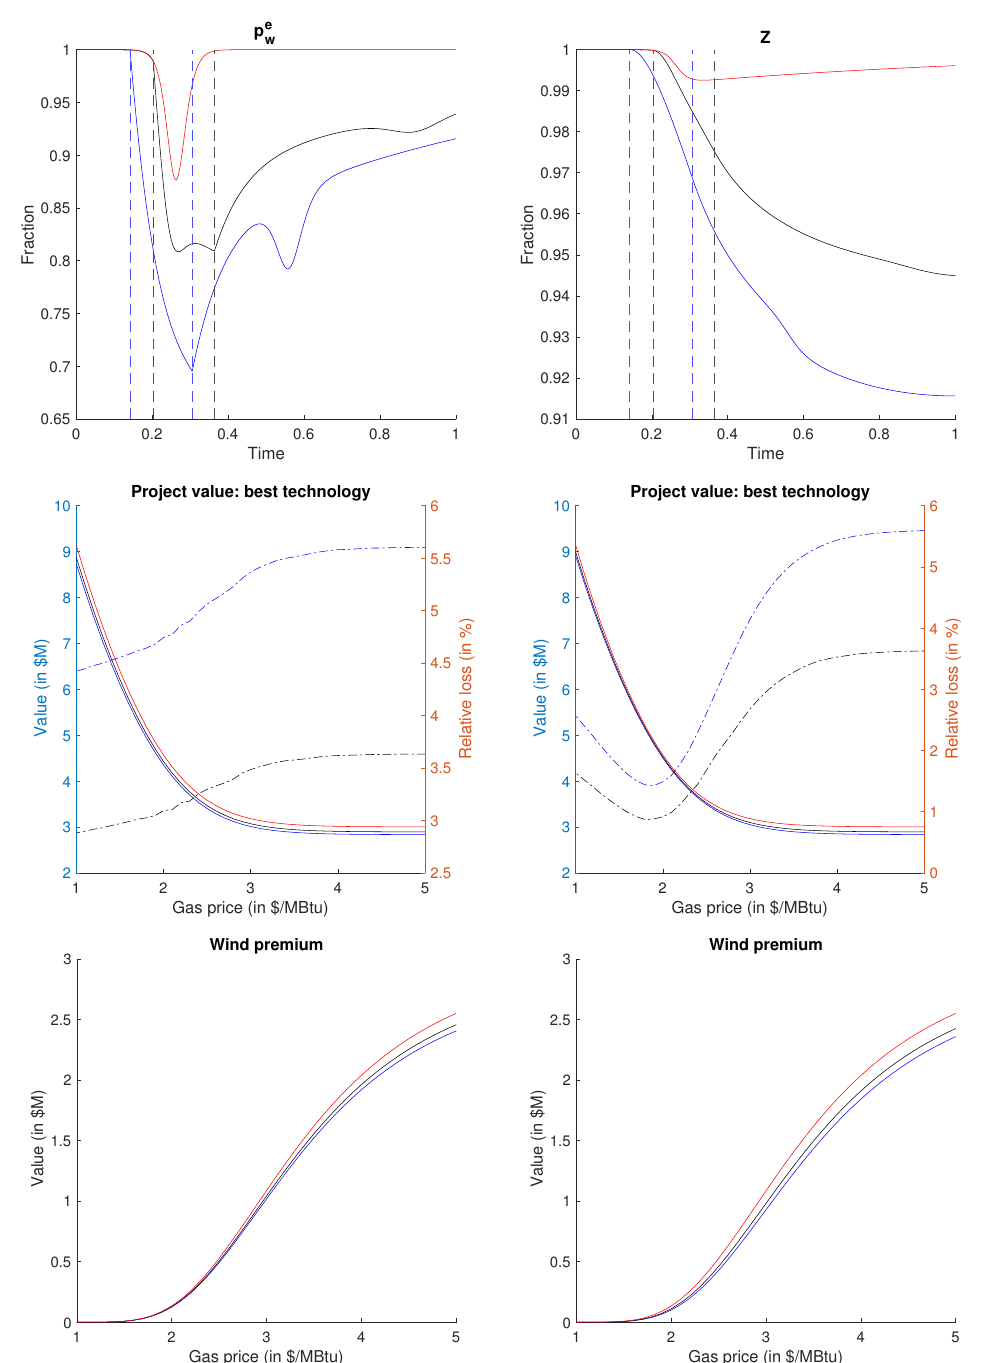
Figure 12. This figure displays the effects of ¯ i 1 on the effective workforce and pandemic factor (left scale, upper panels), project value (middle panels) and wind premium (lower panels) at t = 0 in case of low sensitivity of the gas price ( C = 0, left panels) and of high sensitivity ( C = 2.5, right panels). Dot-dashed lines in middle panels correspond to the relative loss with respect to the no-pandemic case (right scale). The value of X 0 is 50$/MWh. The values of ¯ i 1 are: ¯ i 1 = 120/327,000 (blue), ¯ i ¯ i = + ∞ (red). Other parameter values are given in Table 1; the investment horizon is T = 1 1 = 5000/327,000 (black), 1